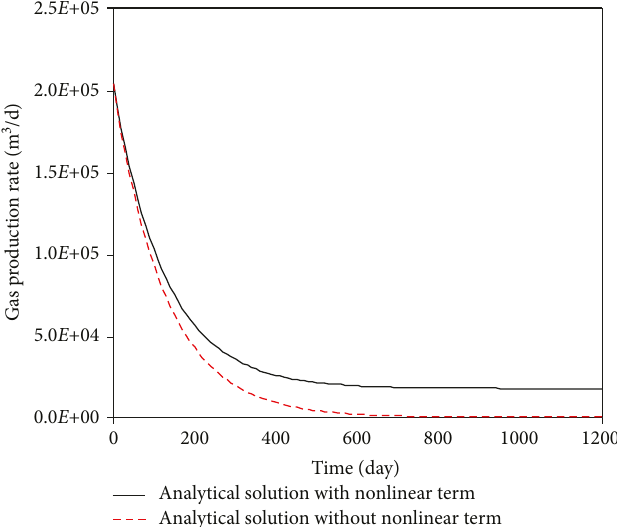
Figure 5: Model veri fi cations of long-term production of a horizontal Barnett shale reservoir.